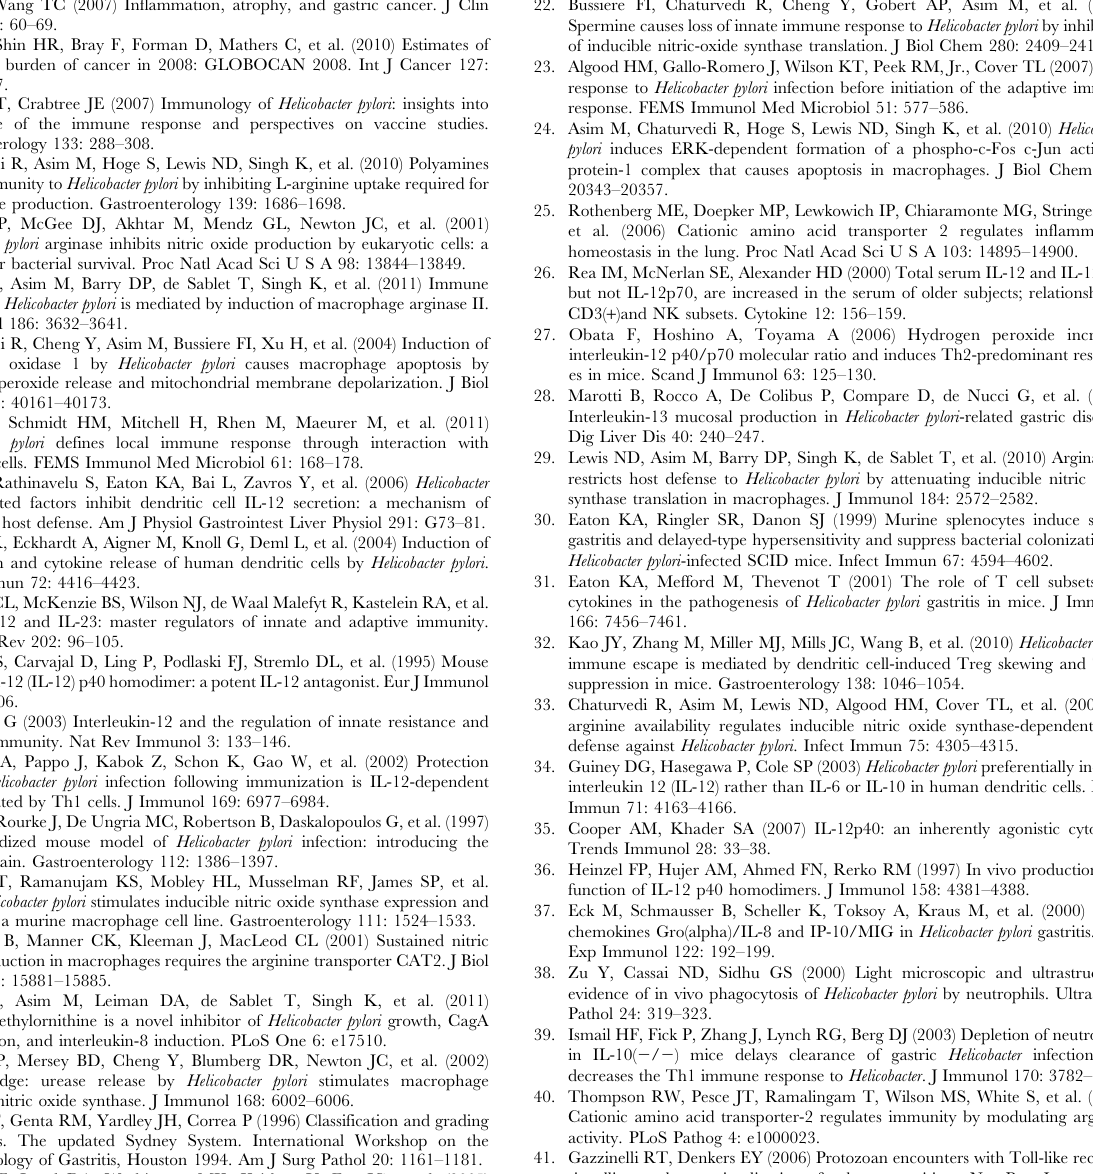
Figure S3 Expression of chemokines induced by H. pylori infection is insensitive to the presence of CAT2. Protein lysates were analyzed by Luminex for expression levels of other cytokines. (A) RANTES levels. (B) KC levels. Each point represents a single mouse ( n = 4–13 per group). **, p , 0.01; ***, p , 0.001 for comparisons indicated.